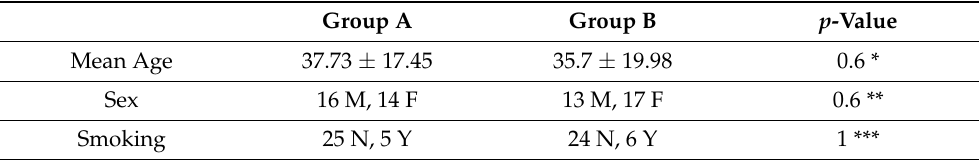
Table 1. Demographical analysis of the